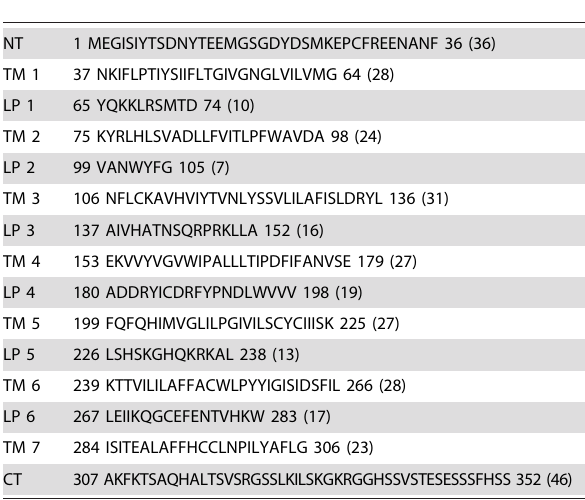
Table 1. Predicted transmembrane regions of the human CXCR4